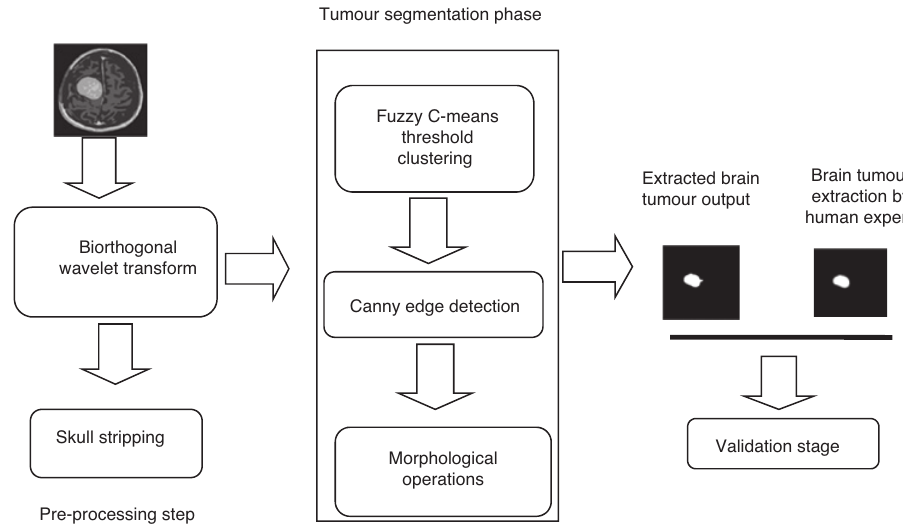
Figure 1: Framework of Tumour Extraction.